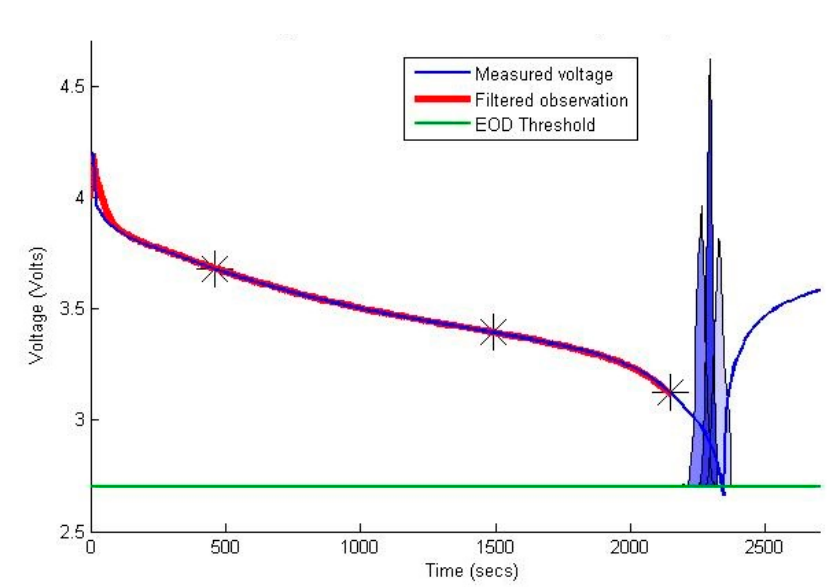
Figure 14. EOD prediction in discharge cycle 160 of cell B0005.